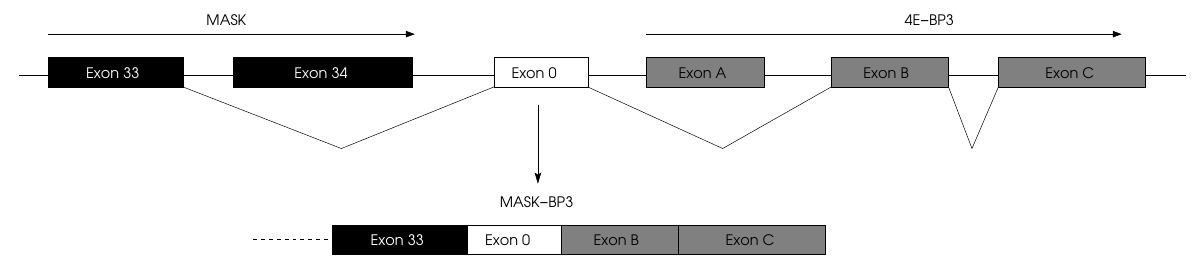
Figure 3: Schematic diagram of chimeric transcript MASK-BP3. Boxes represent exons, which are identified with numbers for MASK and letters for 4E-BP3.